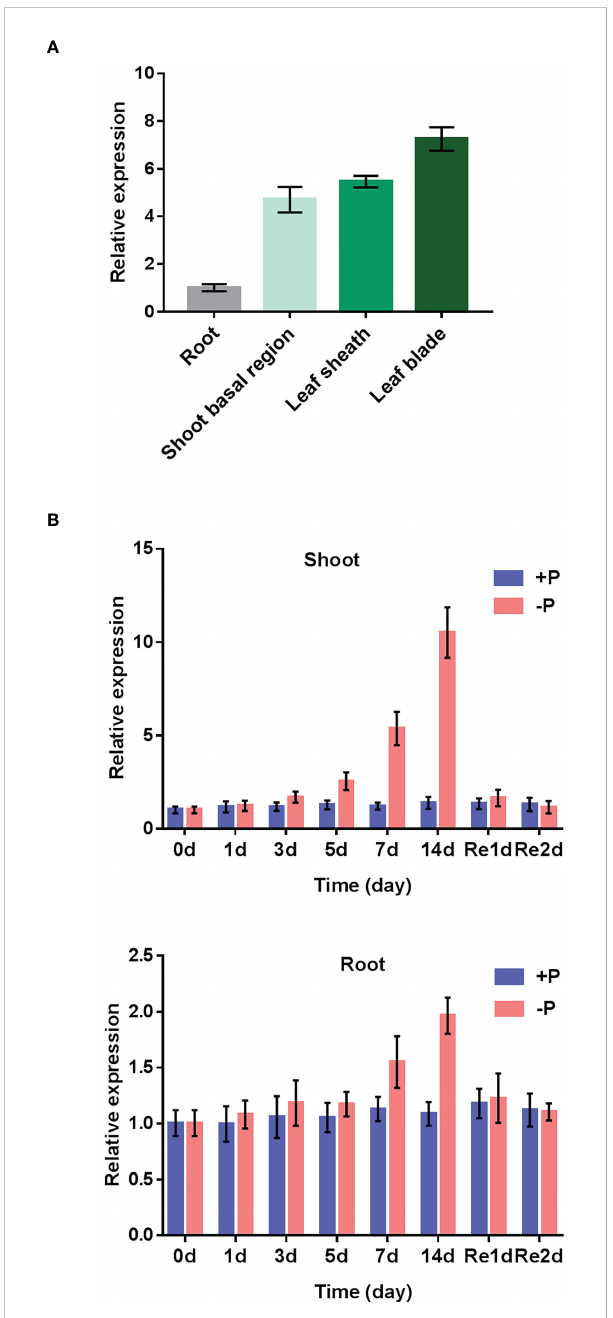
FIGURE 2 Expression patterns of OsAAD gene. (A) Gene expression in roots, shoot basal region, leaf sheath and leaf blade that were separately sampled at the six-leaf-old stage under normal Pi supply. (B) Four- leaf-old seedlings transferred into nutrient solution supplied with normal (200 m M Pi) or low (10 m M Pi) for 14 d, and then resupplied with normal Pi for 2 d. The shoots and roots were sampled at the beginning (0 d) and 1, 3, 5, 7 and 14 d after the treatment, and 1 and 2 d after the resupply of Pi. Values represent means ± SD of three biological